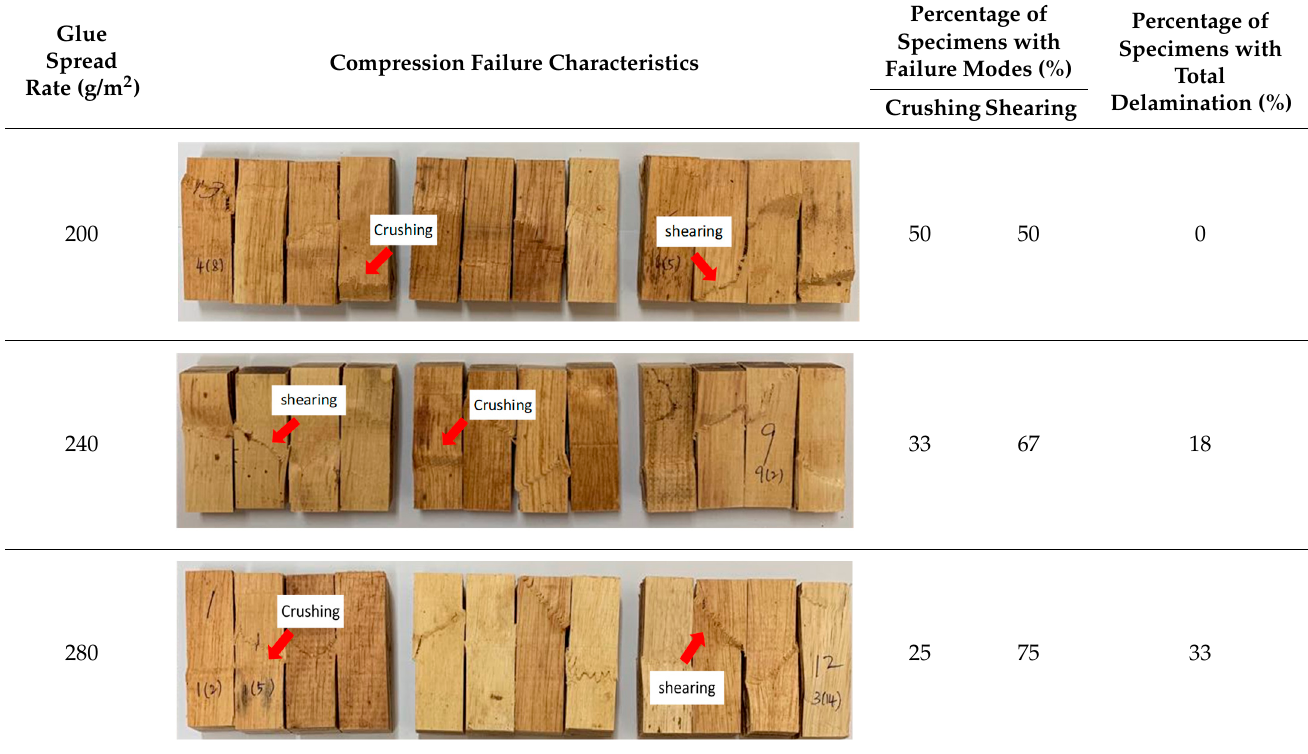
Table 5. Compression failure of rubberwood LVL bonded with different glue spread rates.